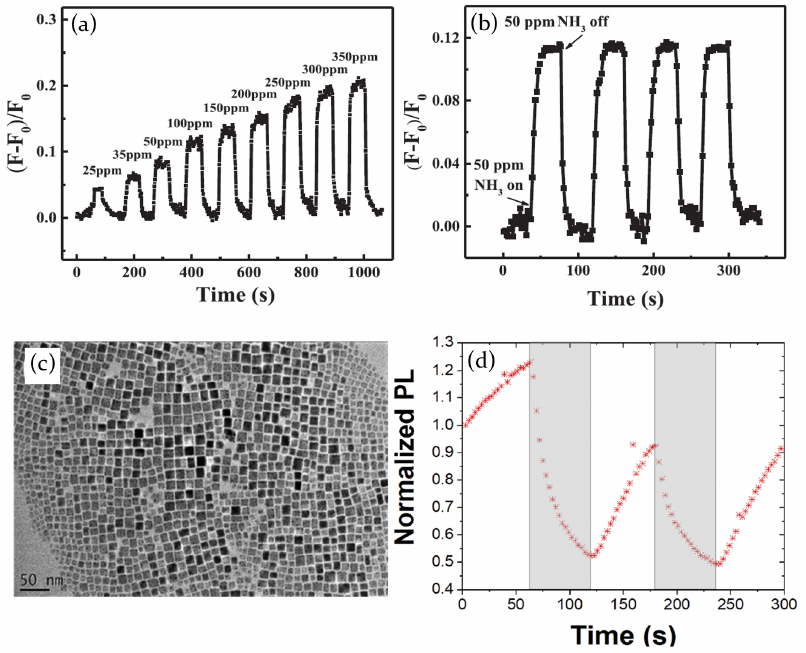
Figure 24. ( a ) Dynamic sensing response of CsPbBr 3 quantum dots (QDs) for different NH 3 concen- trations (from 25 to 350 ppm). ( b ) Four successive sensing cycles of the CsPbBr 3 QDs at 50 ppm. Adapted with permission from [86]. Copyright © 2020, WILEY-VCH Verlag GmbH and Co. KGaA, Weinheim. ( c ) Transmission electron microscopy images of CsPbBr 3 nanocrystals. ( d ) Photolumi- nescence emission as a function of time for a CsPbBr 3 nanocrystal film under repeated cycles of exposure to pure nitrogen (white areas) and DNT vapors in N 2 (gray areas). Adapted with